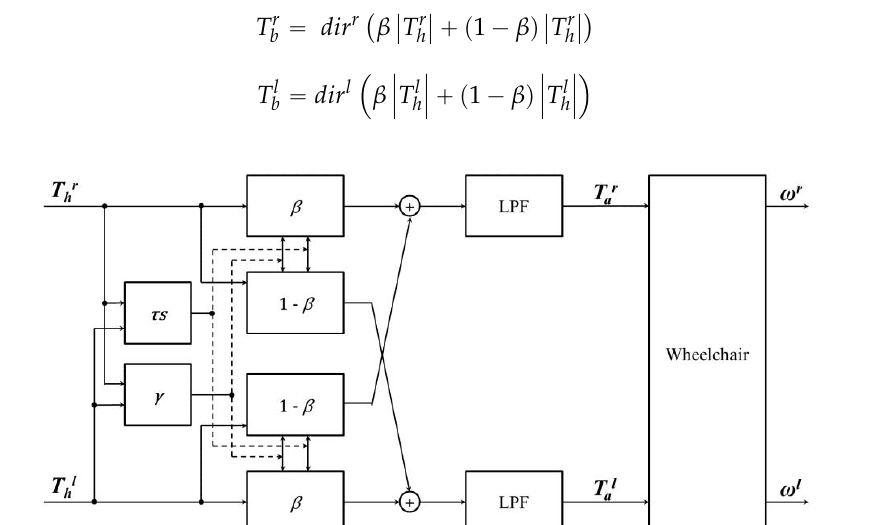
Figure 6. Configuration of system structure for balanced torque generation, where the direction of balanced torques is the same as those of the input torques [13].